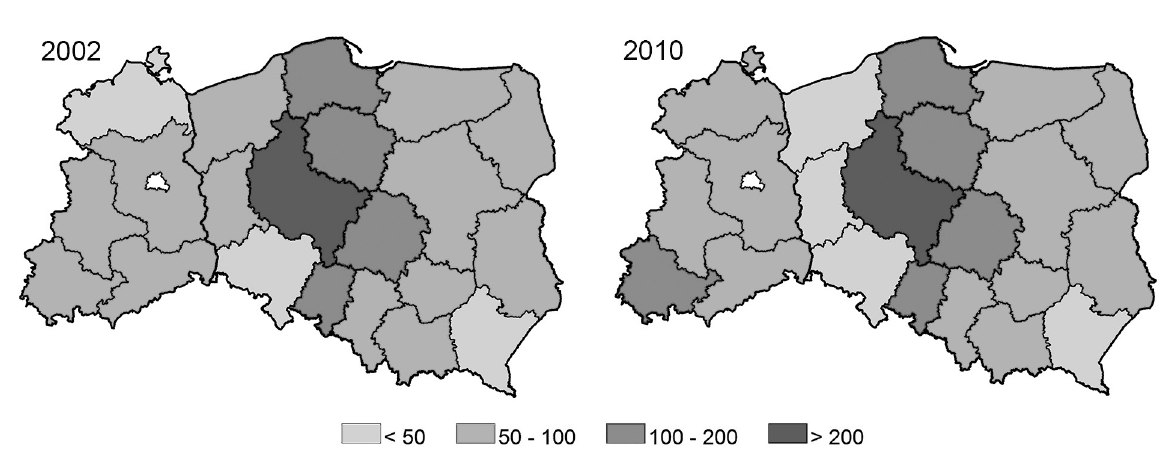
Fig. 7. Pig population per 100 ha of agricultural land in Poland and East Germany in 2002 and 2010 Source: authors’ own calculation based on German 2011 data and Polish 2002 and 2010 Agricultural